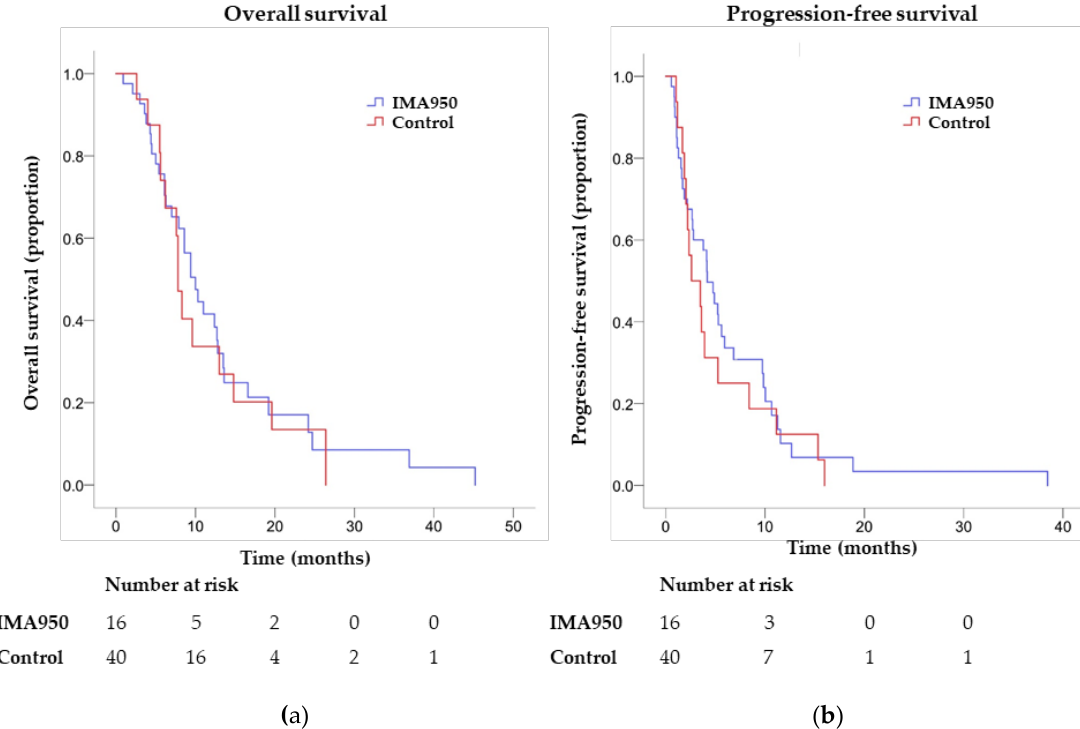
Figure 2. Survival analysis from BEV initiation in control versus IMA950 patients. ( a ) Overall survival ( p = 0.69); ( b ): Progression-free survival ( p = 0.50).